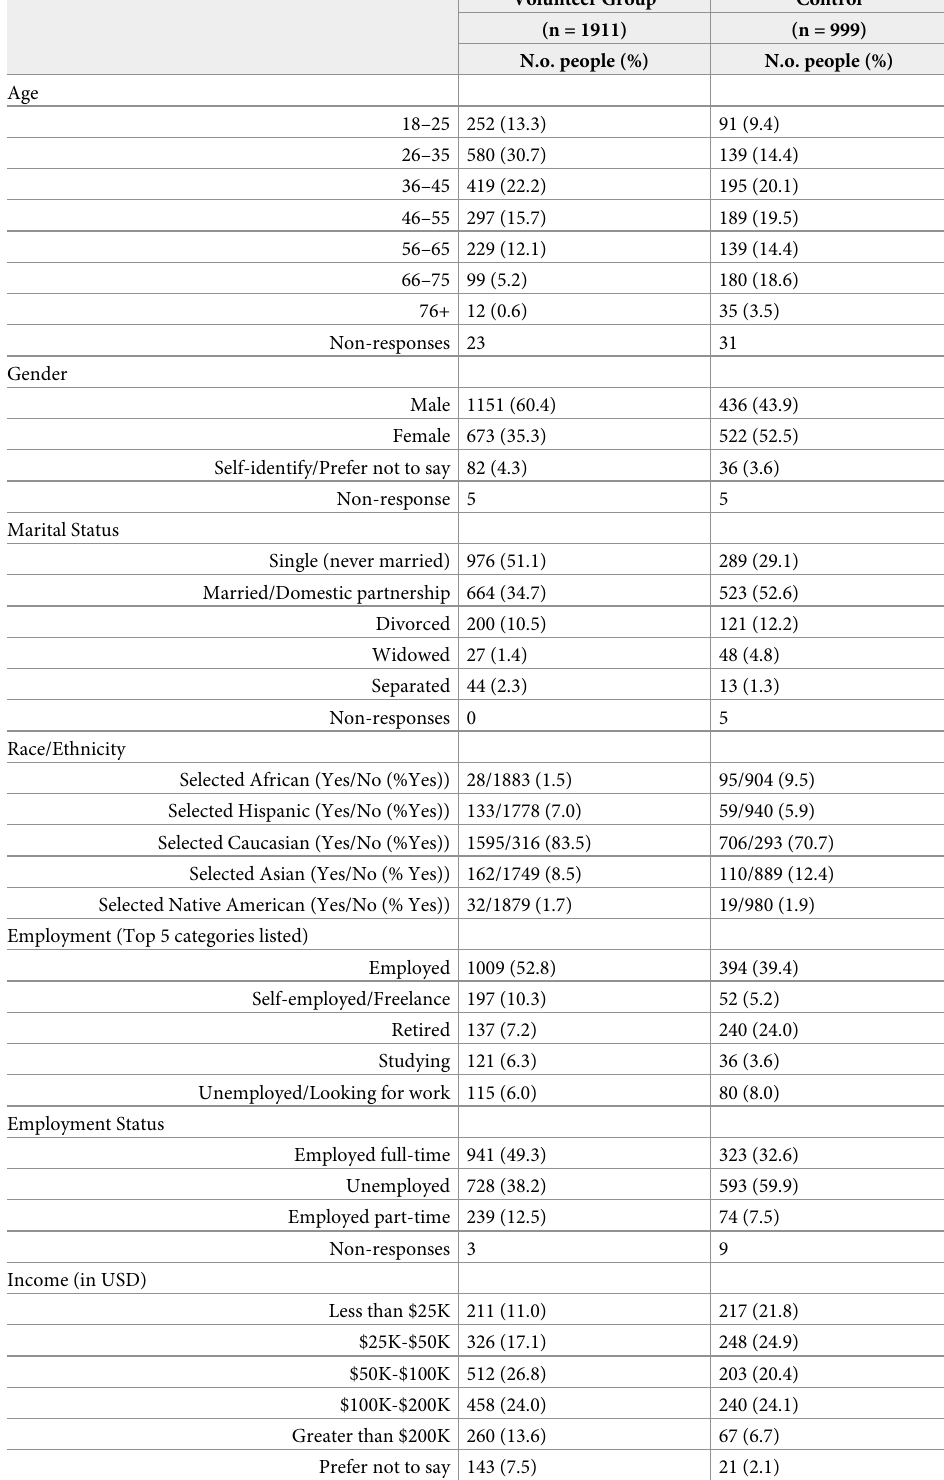
Table 1. Participant demographic